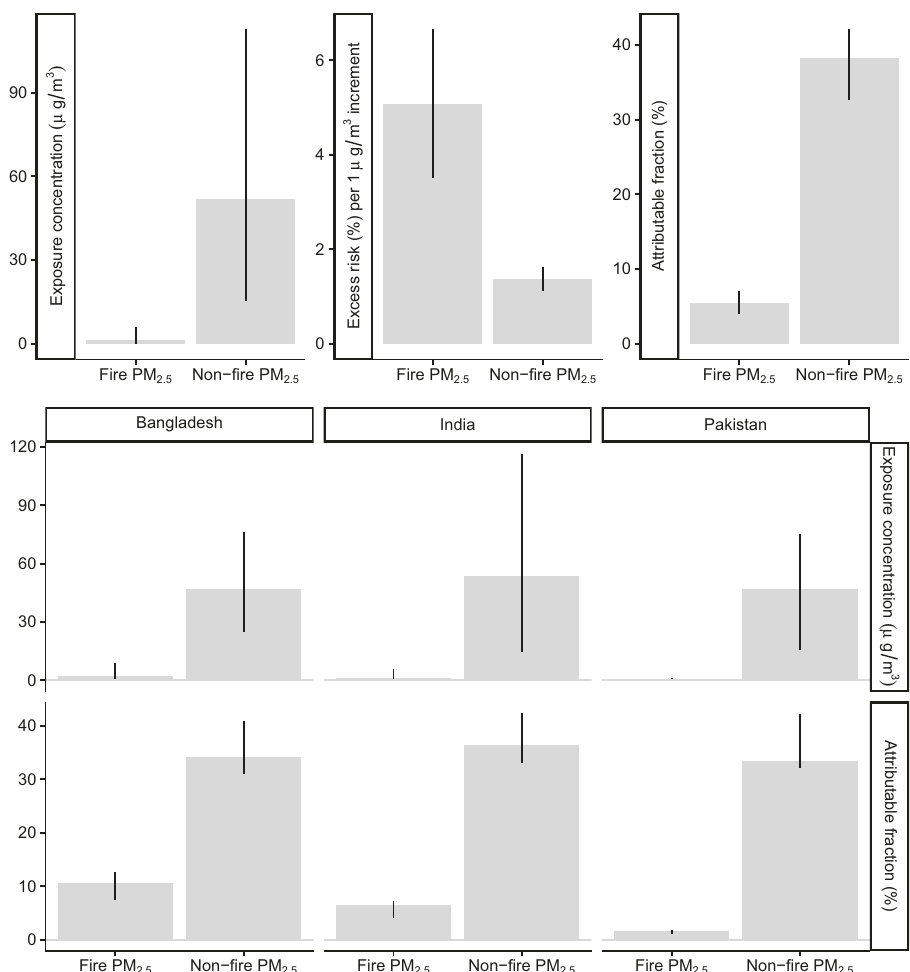
Fig. 5 Health impacts of PM 2.5 from fi re and non- fi re sources. The top panels present the comparisons between open fi re and non- fi re PM 2.5 in terms of exposure concentration, association magnitude, and attributable fraction. The bottom panels present the country-speci fi c comparisons. The bars denote point-estimates, and the error bars denote the corresponding 95% con fi dence intervals. All estimates are derived from the full-adjusted model with 24,876 independent mothers. PM 2.5 particulate matter with a diameter of less than 2.5 µ